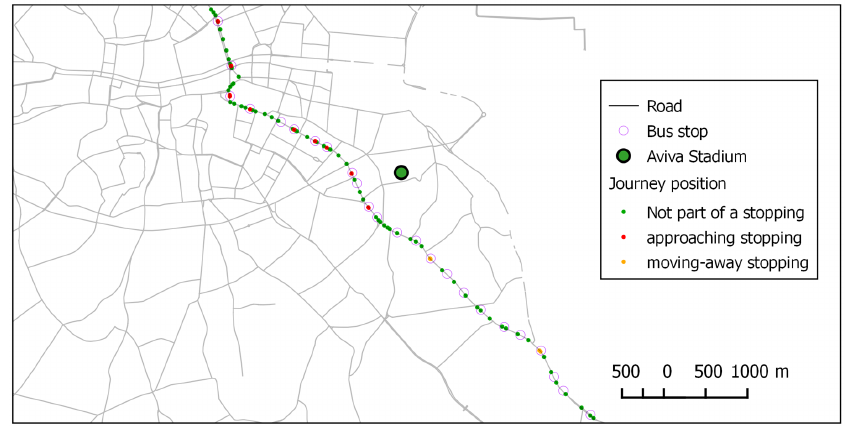
Figure 4. Interactions extracted on a journey segment.